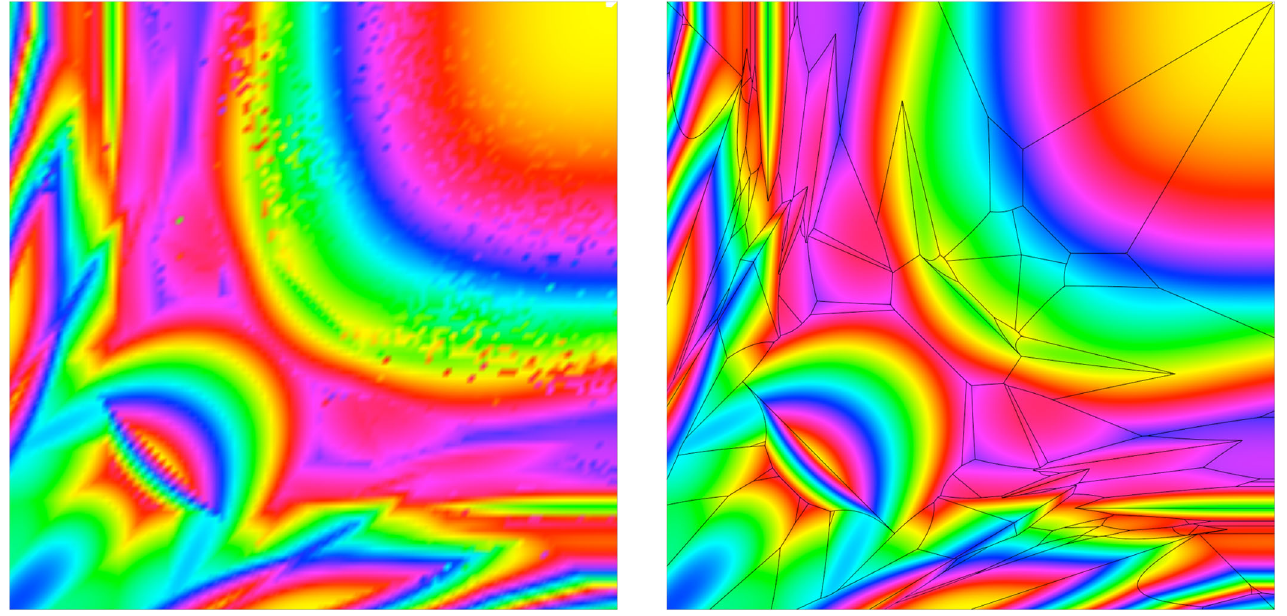
.FIG. 16 Contours of optimal packing density ϕ for the 323 · 2 family, numeric (left) versus analytic (right). The color gradient {blue, magenta, red, yellow, green, cyan, and blue} represents the ϕ gradient f ϕ − 3 ϕ þ 3 ; yellow contours occur at ϕ ¼ f 8 60 g